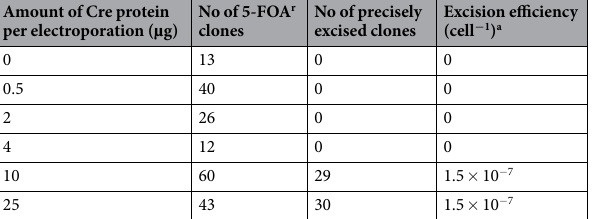
Table 1. Excision efficiency of the loxP_cUMPS_loxP sequence by electroporated Cre recombinase. a The efficiency was calculated by the number of precisely excised clones divided by the number of cells used for